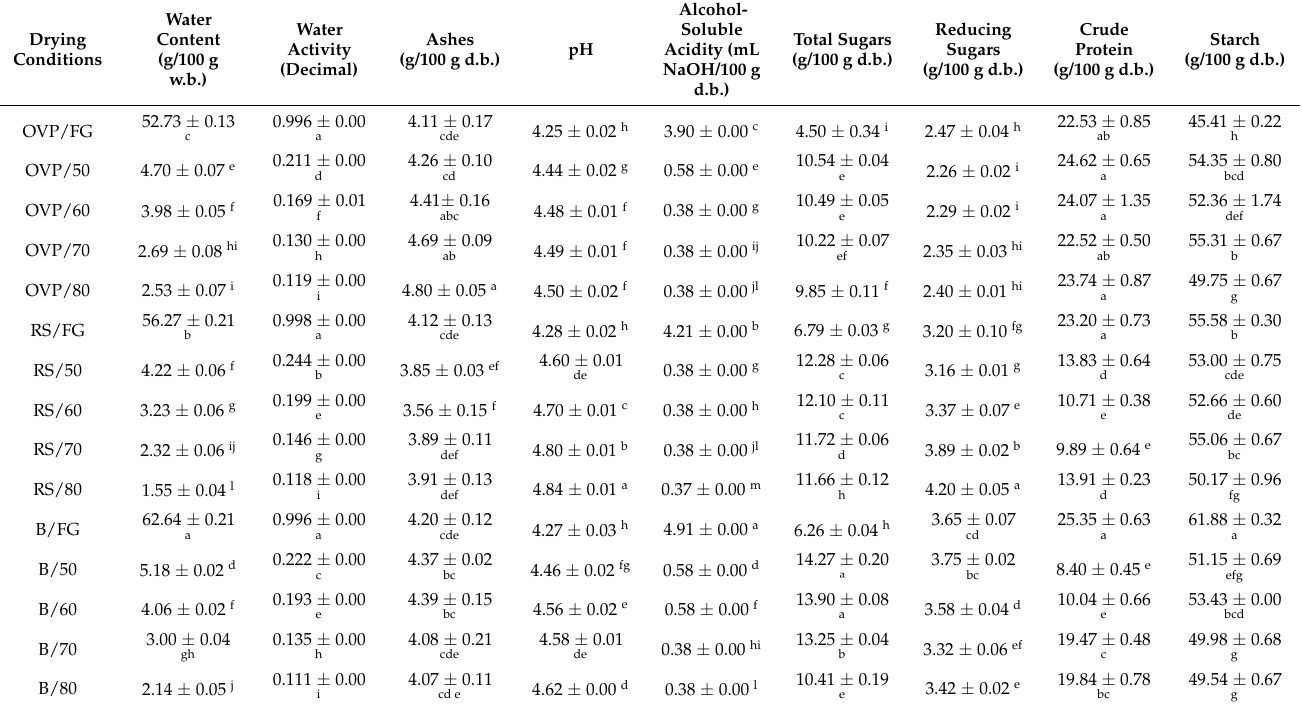
Table 7. Physicochemical parameters of fresh fava bean germinated seeds and flour from germinated samples dried at different